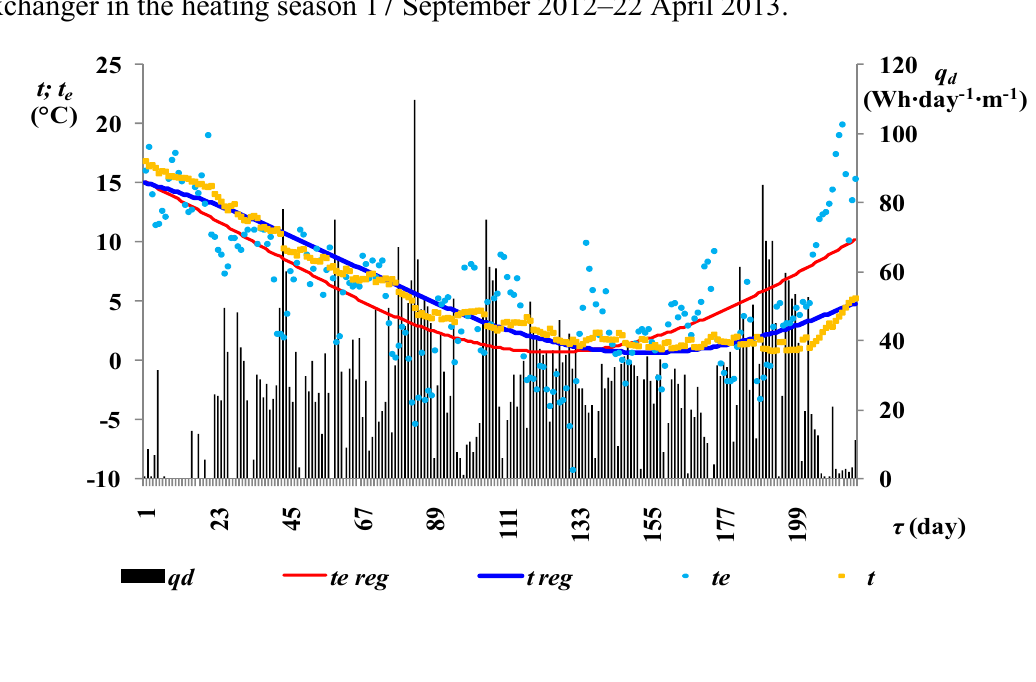
Figure 3. Temperatures of the soil and heat discharged to a soil containing a slinky